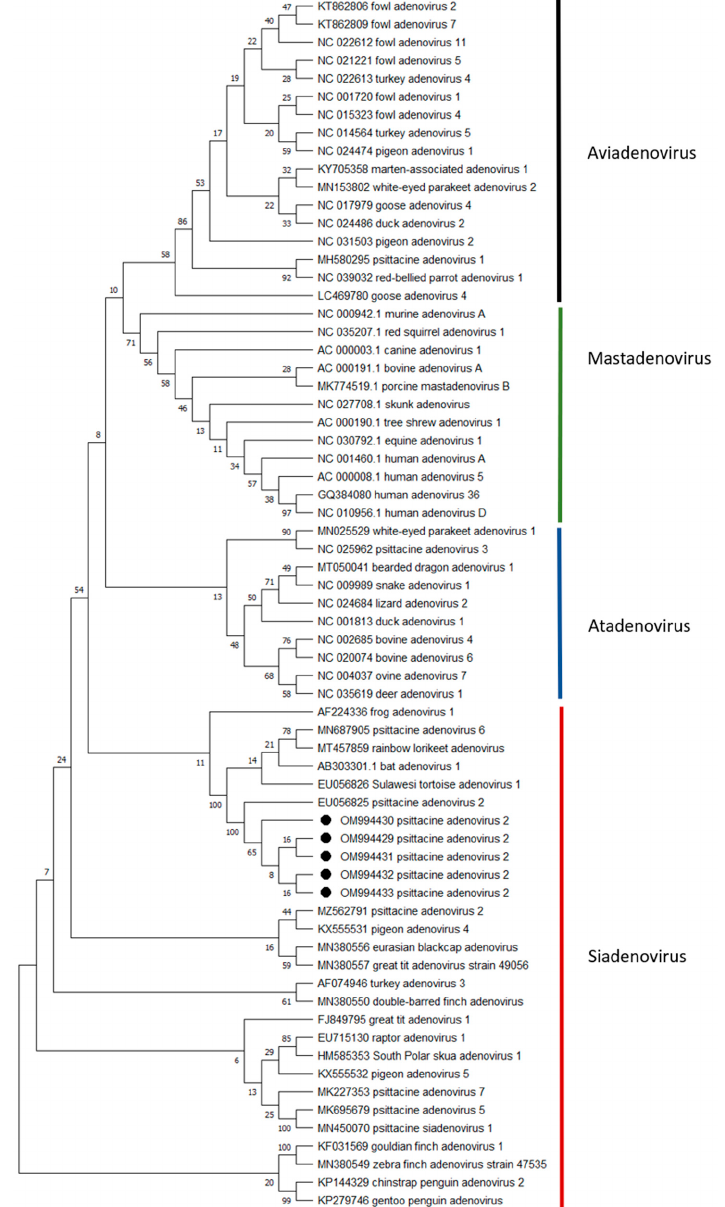
Figure 5. Phylogenetic analysis based on partial polymerase gene sequences (311 position, shorter sequences were excluded) of five sequences from this study in comparison to sequences of 62 reference sequences from NCBI. The five sequences belonging to this study are marked with a black circle.